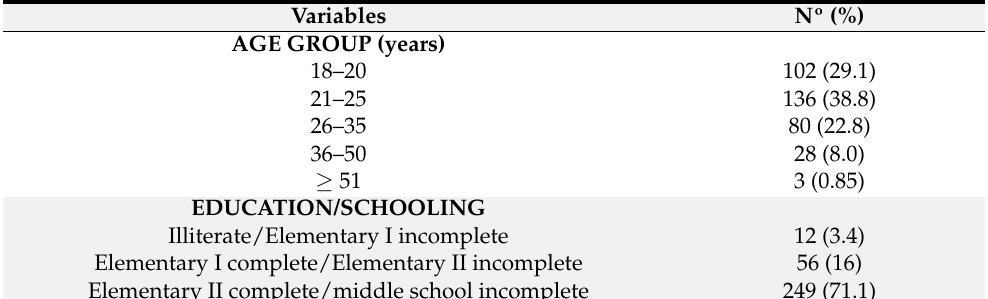
Table 1. Sociodemographic characteristics of men who have sex with men in Bel é m, Par á , Brazil,